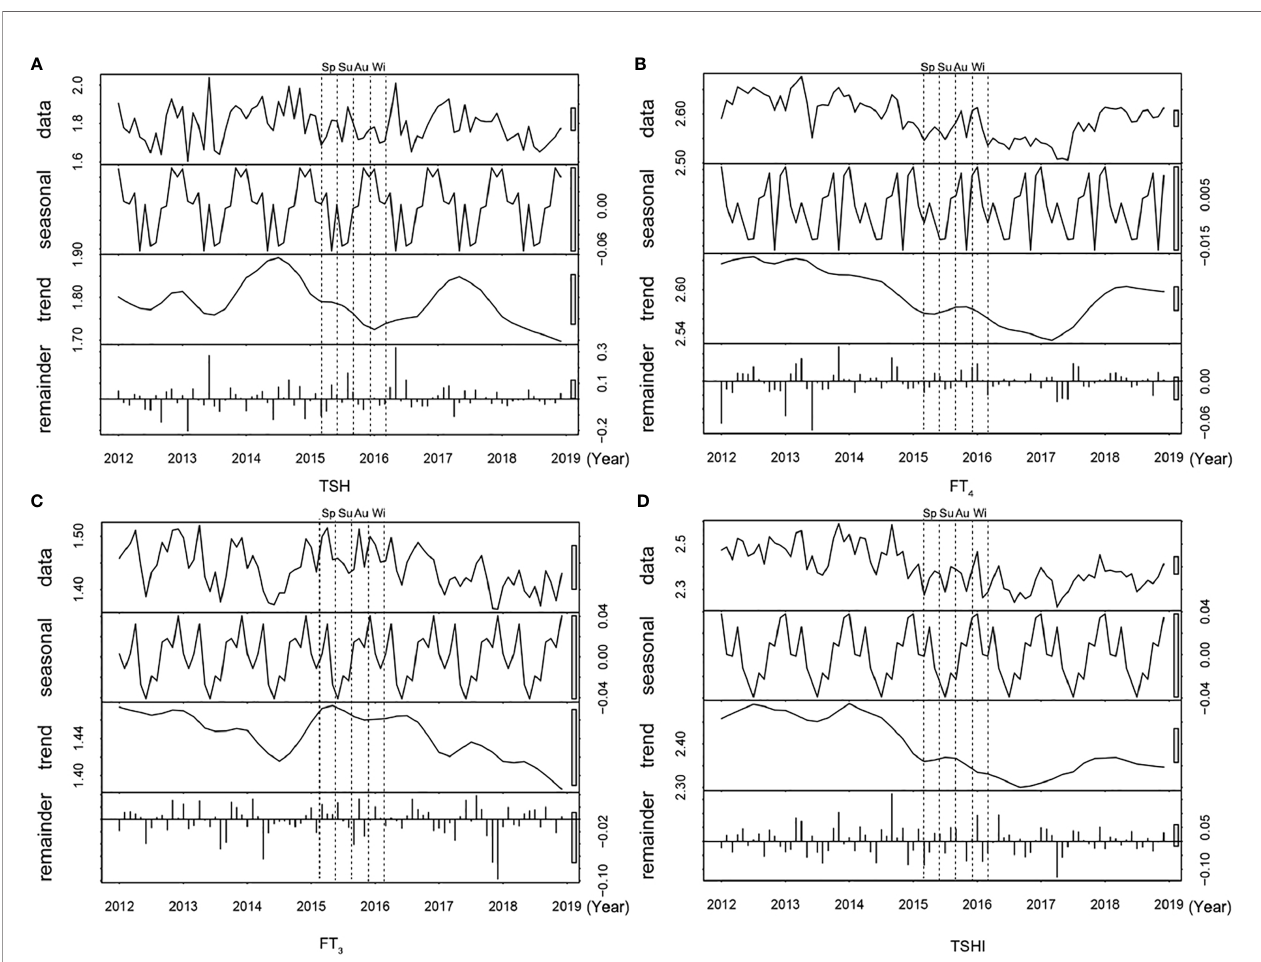
FIGURE 2 | Time series plot of thyroid parameters over 7 years. The distribution (row 1), seasonal trend (row 2), time trend (row 3), and residuals (row 4) are shown for (A) TSH, (B) FT 4 , (C) FT 3 levels, and (D) TSHI. Abbreviations: Sp, Spring; Su, Summer, Au, Autumn; Wi, Winter; TSH, thyrotropin; FT 3 , free triiodothyronine; FT 4 , free thyroxine; TSHI, TSH